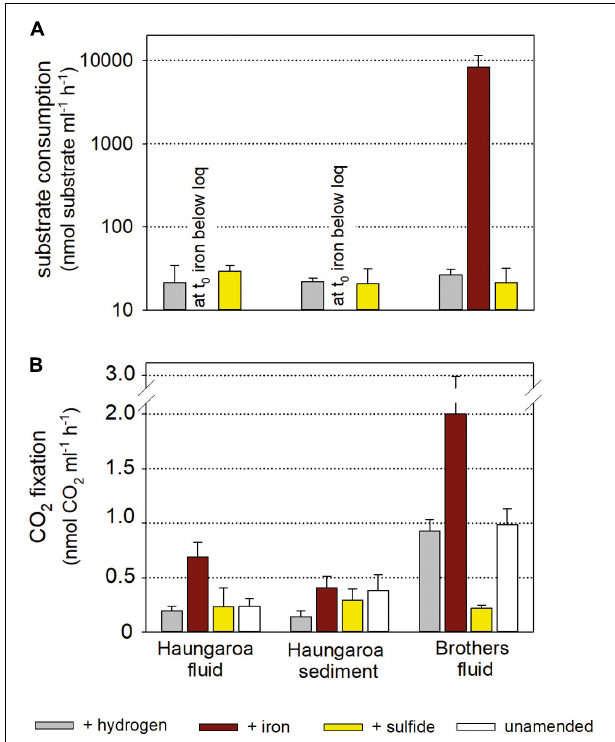
FIGURE 5 | Substrate consumption (A) and CO 2 fixation per volume (B) for experiments with Kermadec hydrothermal fluids (30 ROV 4F) and sediment (35 ROV 15M) from Haungaroa and fluids from Brothers (61 ROV 13F-15F). The differently colored bars denote whether the incubated fluid remained unamended (white), supplemented with sulfide (yellow), hydrogen (gray), or iron(II)